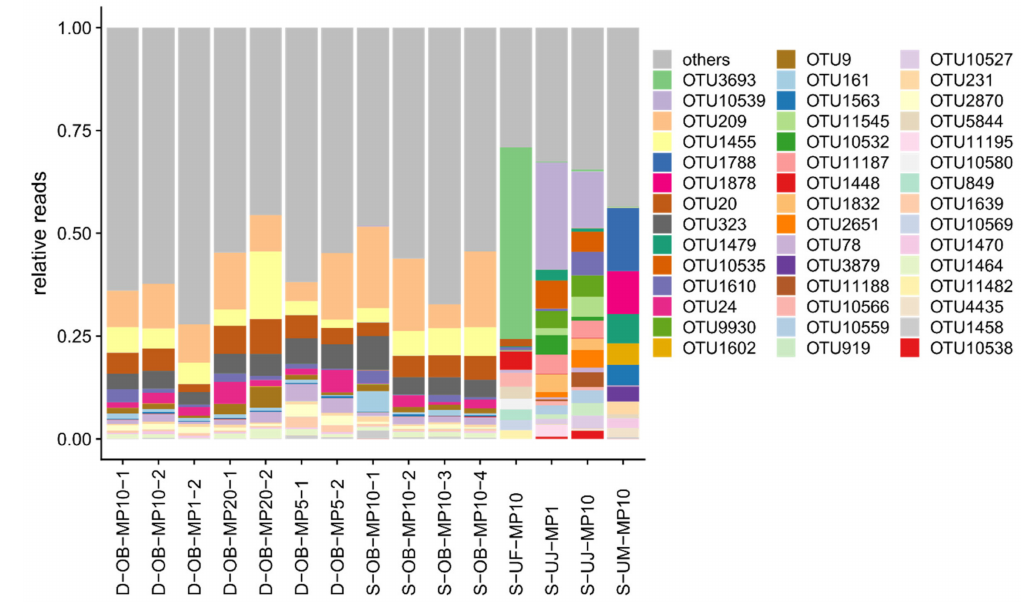
Figure 2. Relative frequencies of Mimiviridae OTUs across samples. Forty-four OTUs are represented by bars with colors if their relative frequencies reach at least 2% in any dataset, otherwise OTUs are grouped together in the “others” category.